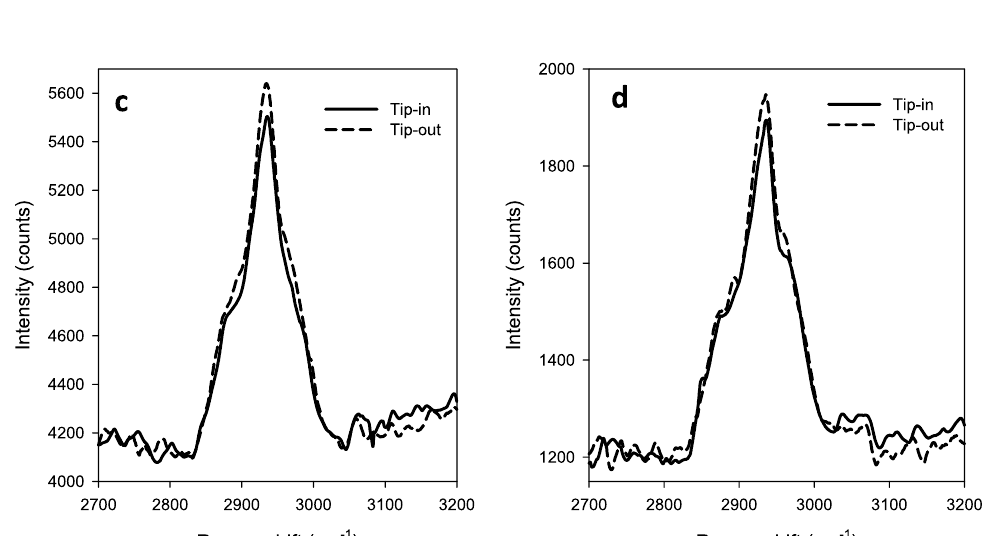
spectra of different bacterial species vary in all regions except for the membrane’s Raman shift region at 2800– 3000 cm − 1 . Since the structural differences between Gram negative and Gram positive bacteria rely namely on the lipid bilayers membrane, which can be found only on the surface of Gram negative bacteria, we focus on this region. Figure 3 shows the Raman spectra in the spectral range of 2800–3000 cm − 1 methylene stretching vibra- tions and indicates the differences in the enhancement effect between Gram negative bacteria: Escherichia coli (a) and Pseudomonas aeruginosa (b) and Gram positive bacteria: Bacillus subtilis (c) and Staphylococcus aureus (d). For Gram negative bacteria, TERS enhancement is observed, with the signal intensity for Tip-in being more than 60% higher than for Tip-out. For Gram positive bacteria, no enhancement is observed. In fact, a slight reduction in the scattering intensity of approximately 5% is measured due to the tip obstructing the laser excitation and light collection path. These results demonstrate that the TERS tip enhances the Raman scattering from the methylene stretching vibrations of the Gram negative bacterial cell membrane. We can surmise that the outer membrane is certainly enhanced and probably the inner membrane as well, since both membranes are within the depth of the TERS effect, where plasmonic resonance occurs. In Gram positive species, the lack of an outer membrane and a thicker peptidoglycan layer prevent resonant plasmonic Raman scattering from the membrane, hence no enhancement is observed in their Raman spectra. It is notable that in some measurements, for example in Fig. 3b, the background spectra are tilted. This tilt is attributed to the presence of water molecules within the bacteria or adsorbed to